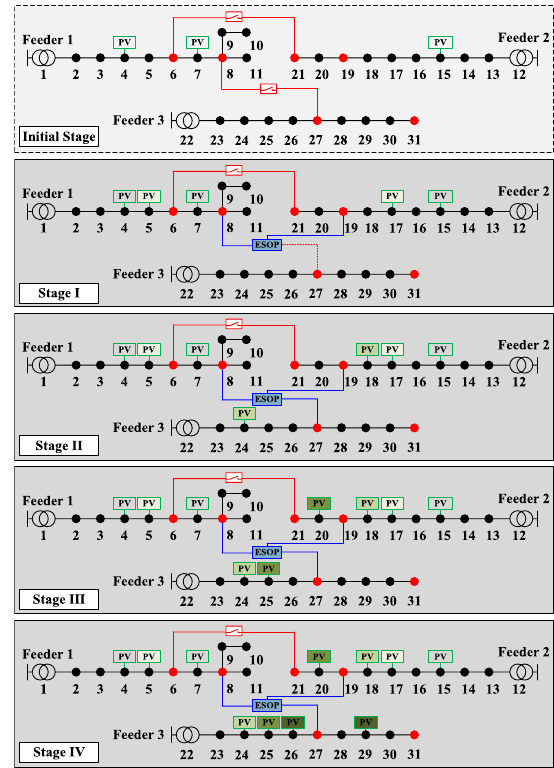
Fig. 8 Planning results of the network based on ESOP in Case V Fig. 9 Planning results of the network based on ESOP in Case VI